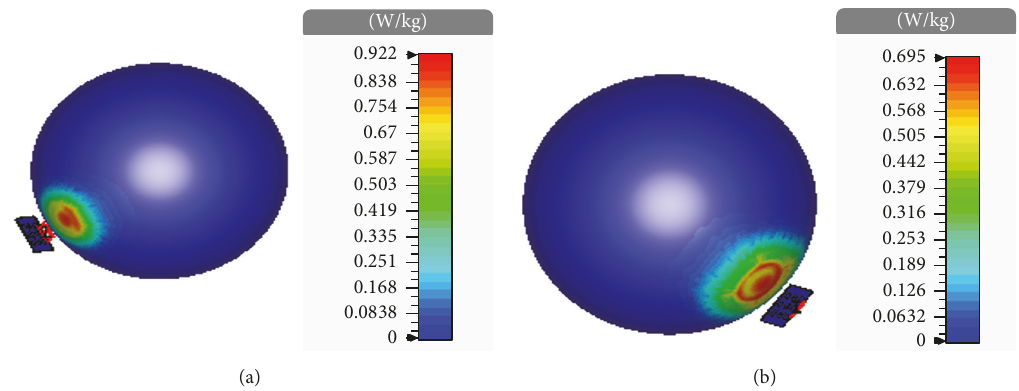
Figure 14: (a) 1g average and (b) 10g average SAR induced inside the human head